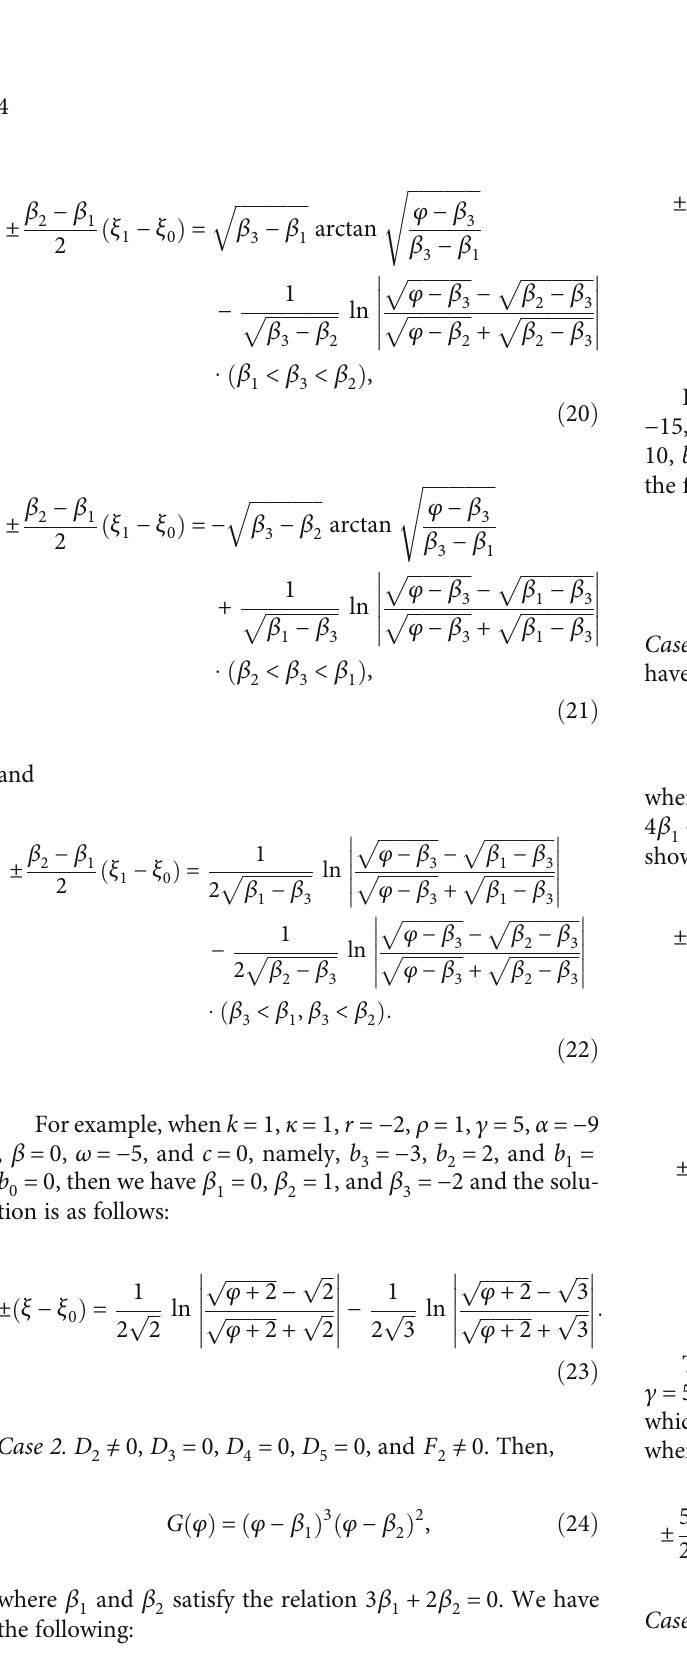
1 ffiffiffiffiffiffiffiffiffiffiffiffiffi ffiffiffiffiffiffiffiffiffiffiffiffiffiffi